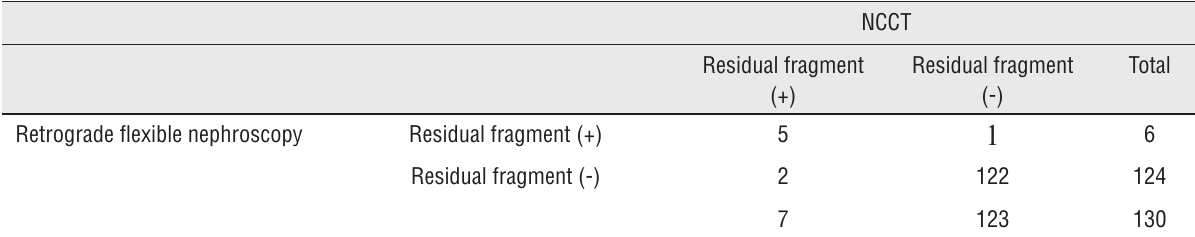
Table 3 - Summary of the stone free rates based on retrograde flexible nephroscopy and NCCT images in 130 patients with successful access to all